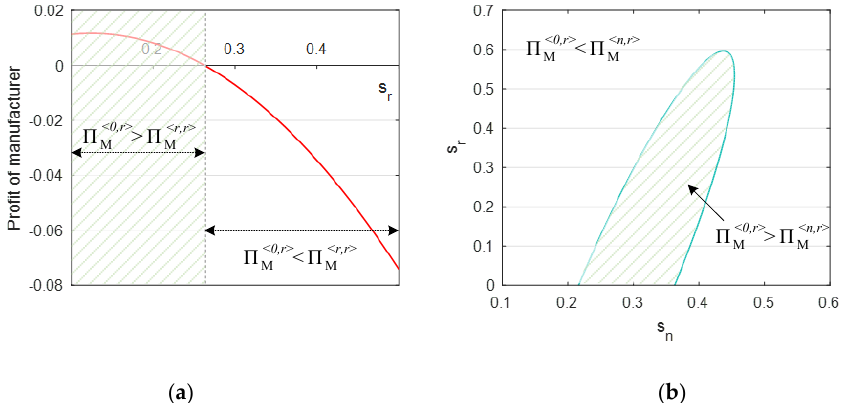
Figure 10. The profits of the manufacturer in the < 0 , r >, < n , r >, and < r , r > scenarios. ( a ) Profits in < 0 , r > and < r , r > scenarios. ( b ) Profits in < 0 , r > and < n , r > scenarios.